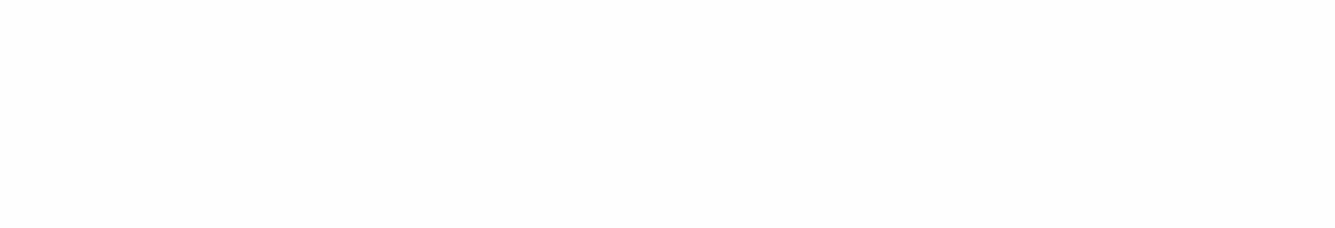
FIGURE 5 Time series of the melnbrane potential (left) and [Ca -]i (right) of the pyramidal neuron as a steady depolarization current, lapp, is increased from the top to the bottom. The values of lap (in unit of l.tA/cnl 2) are listed on the left. Note that the burst generated by PYN is frequency modulation in that the shape remains the same while the frequency increases drastically as lap